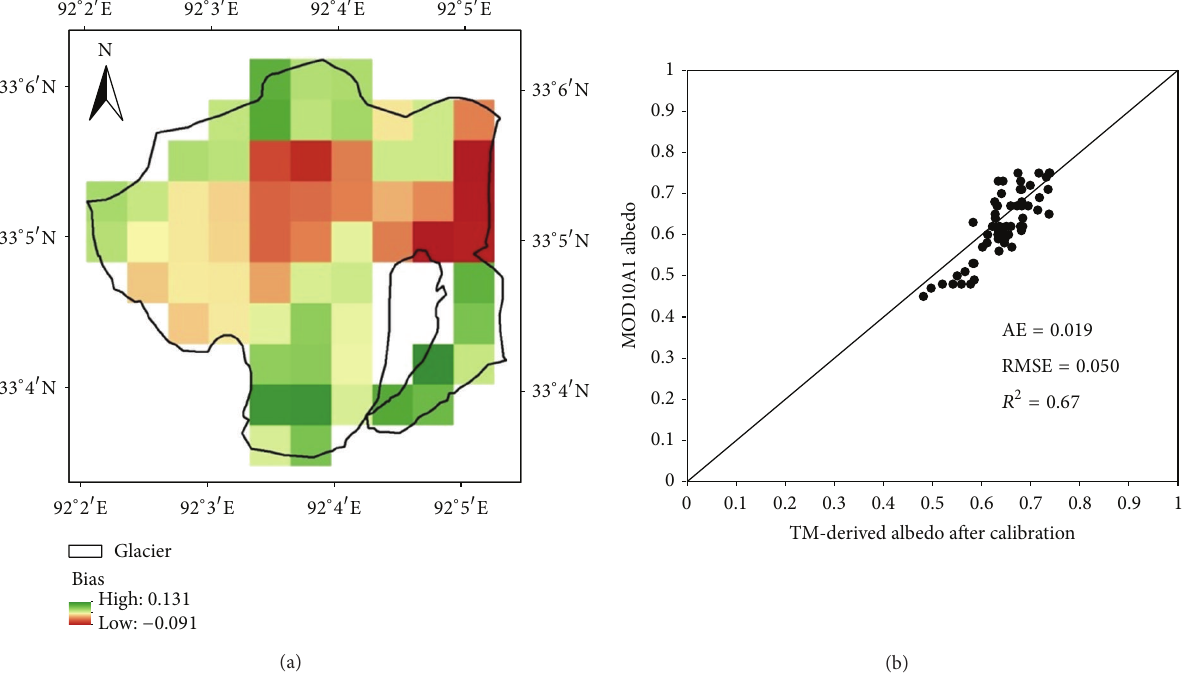
Figure 2: Comparison between calibrated TM-derived albedo and MOD10A1 albedo. (a) The difference; (b) the scatter diagram (date acquired: